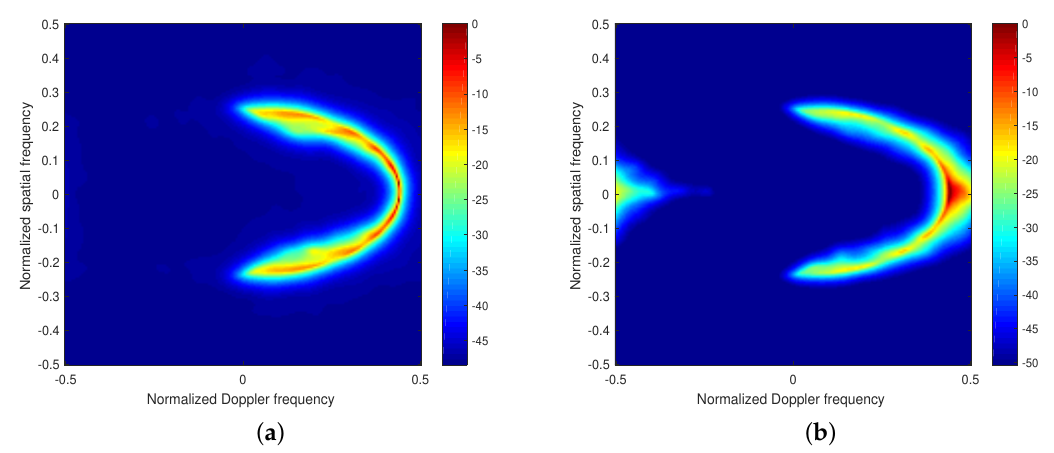
Figure 5. Clutter spectra in traditional PA ( a ) DW compensation without range ambiguity ( b ) DW compensation with range ambiguity.